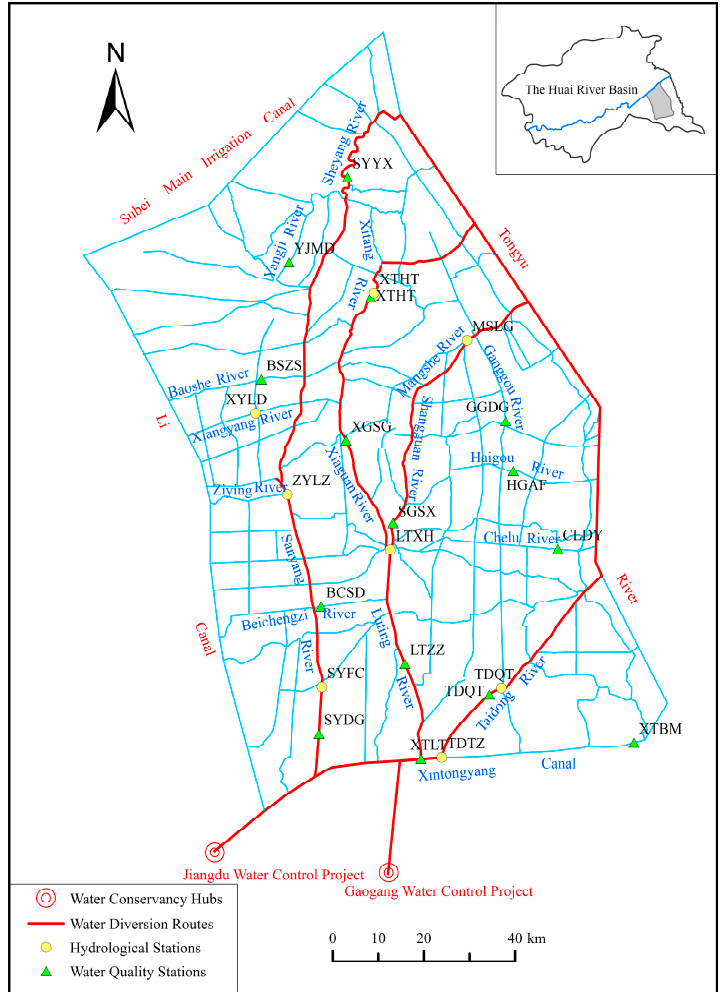
Figure 1. Sketch of river networks and monitoring stations in the Lixiahe abdominal area.